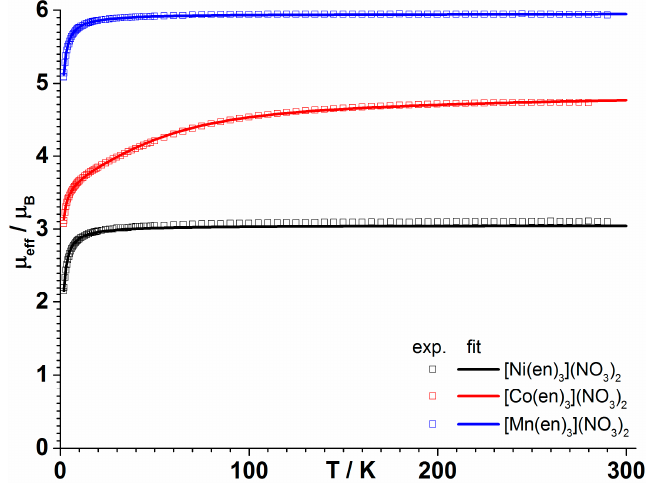
Figure 3. Temperature dependence of μ eff (squares) and the corresponding fit (solid line) at 0.1 T